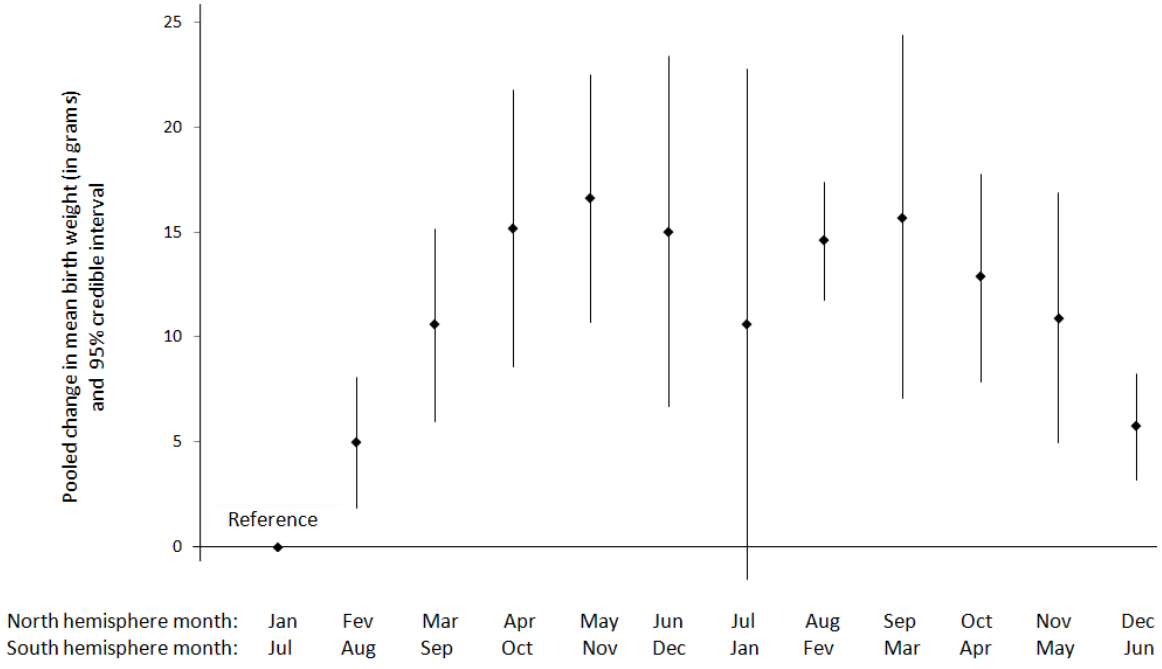
Figure 5. Pooled change in mean birth weight (and 95% credible interval) by month of birth in term born infants ( N = 5,398,360 births).